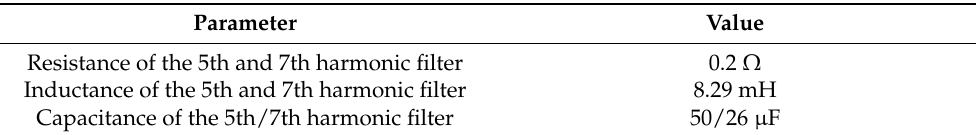
Table 2. The parameters of shunt filter.